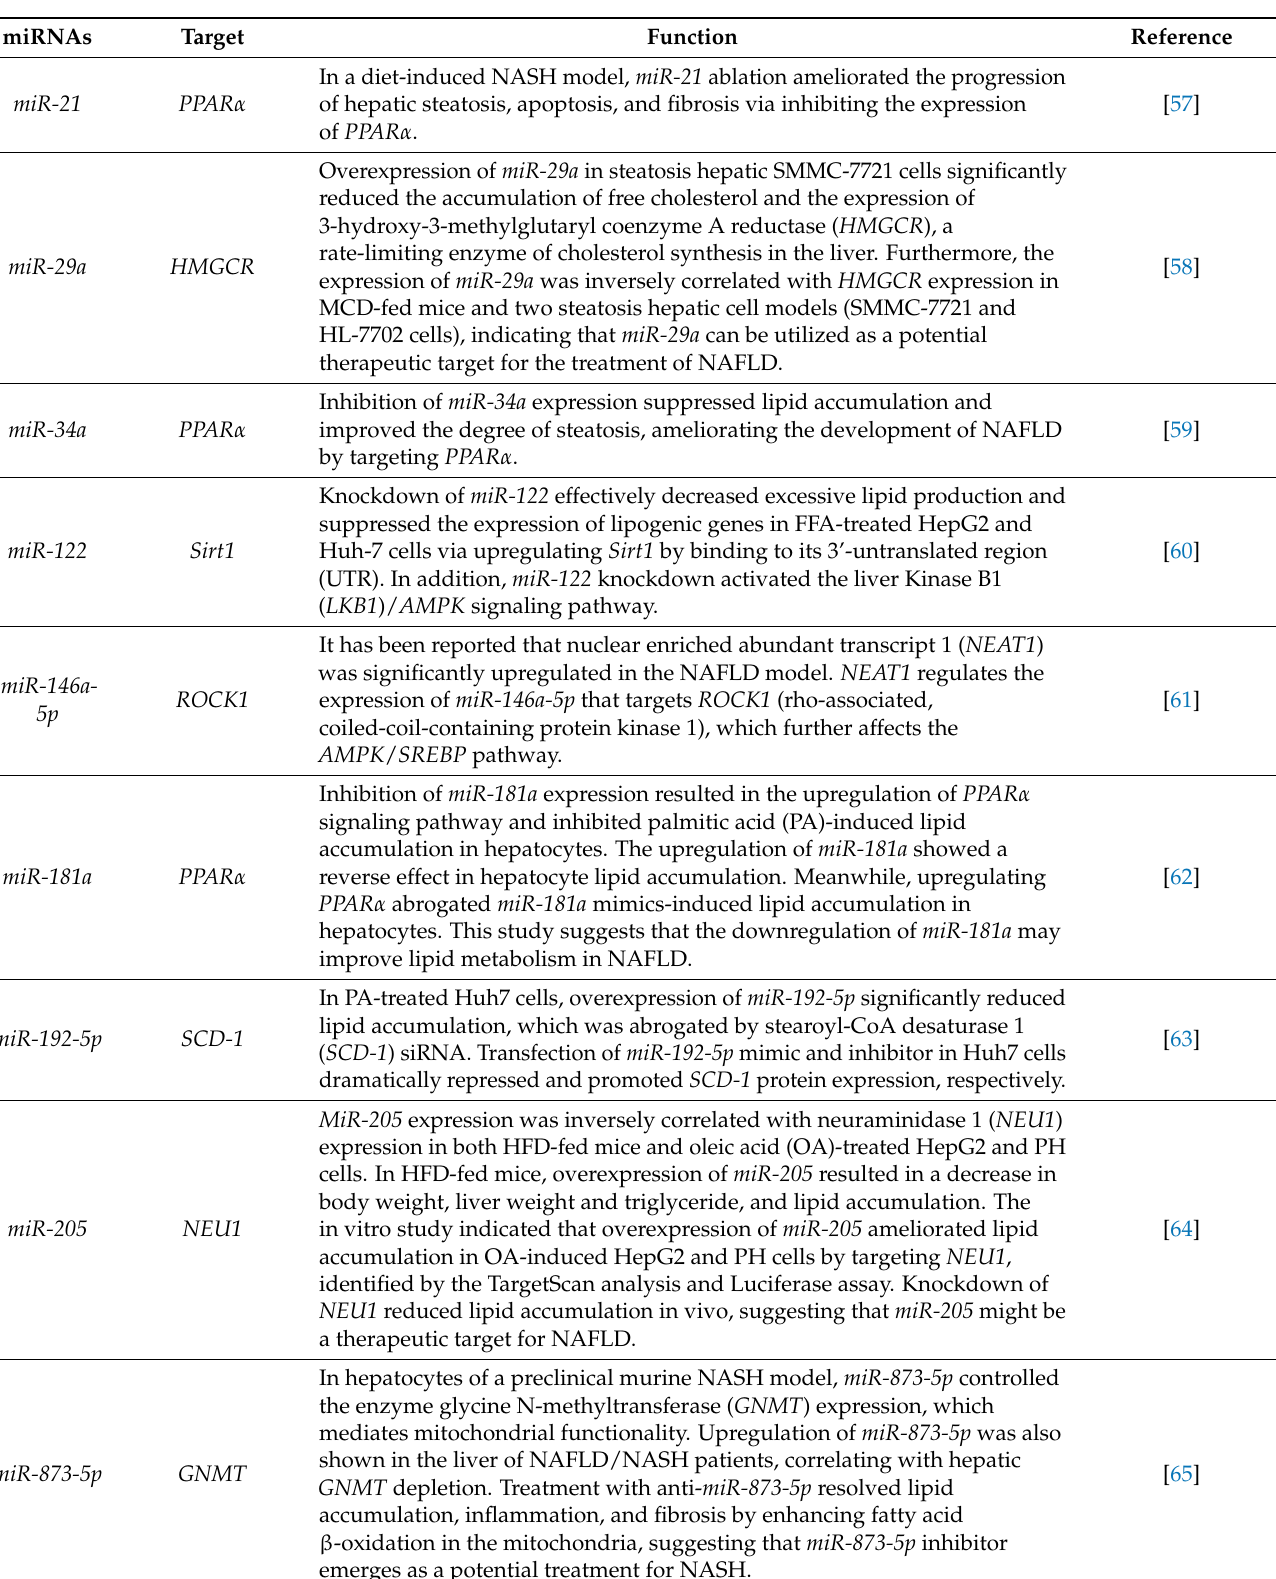
Table 1. The miRNAs-mediated function and therapy in